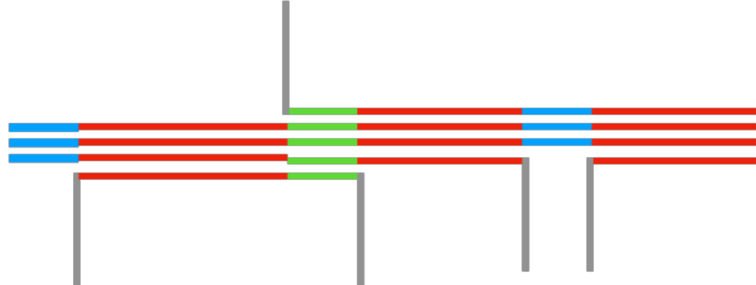
Figure 10 . A schematic picture of typical fraction of string. Each line denotes the (cid:30) 2 -string. Red, blue, and green lines corresponds to ( n 1 ; n 2 ) = (1 ; 4), ( n 1 ; n 2 ) = (1 ; 3), and ( n 1 ; n 2 ) = (1 ; 5) strings, respectively. The gray lines show the string bridges. The strings are cut for drawing (cid:12)gures. respectively. At the point where the color is changed, e.g. from red to blue, it is